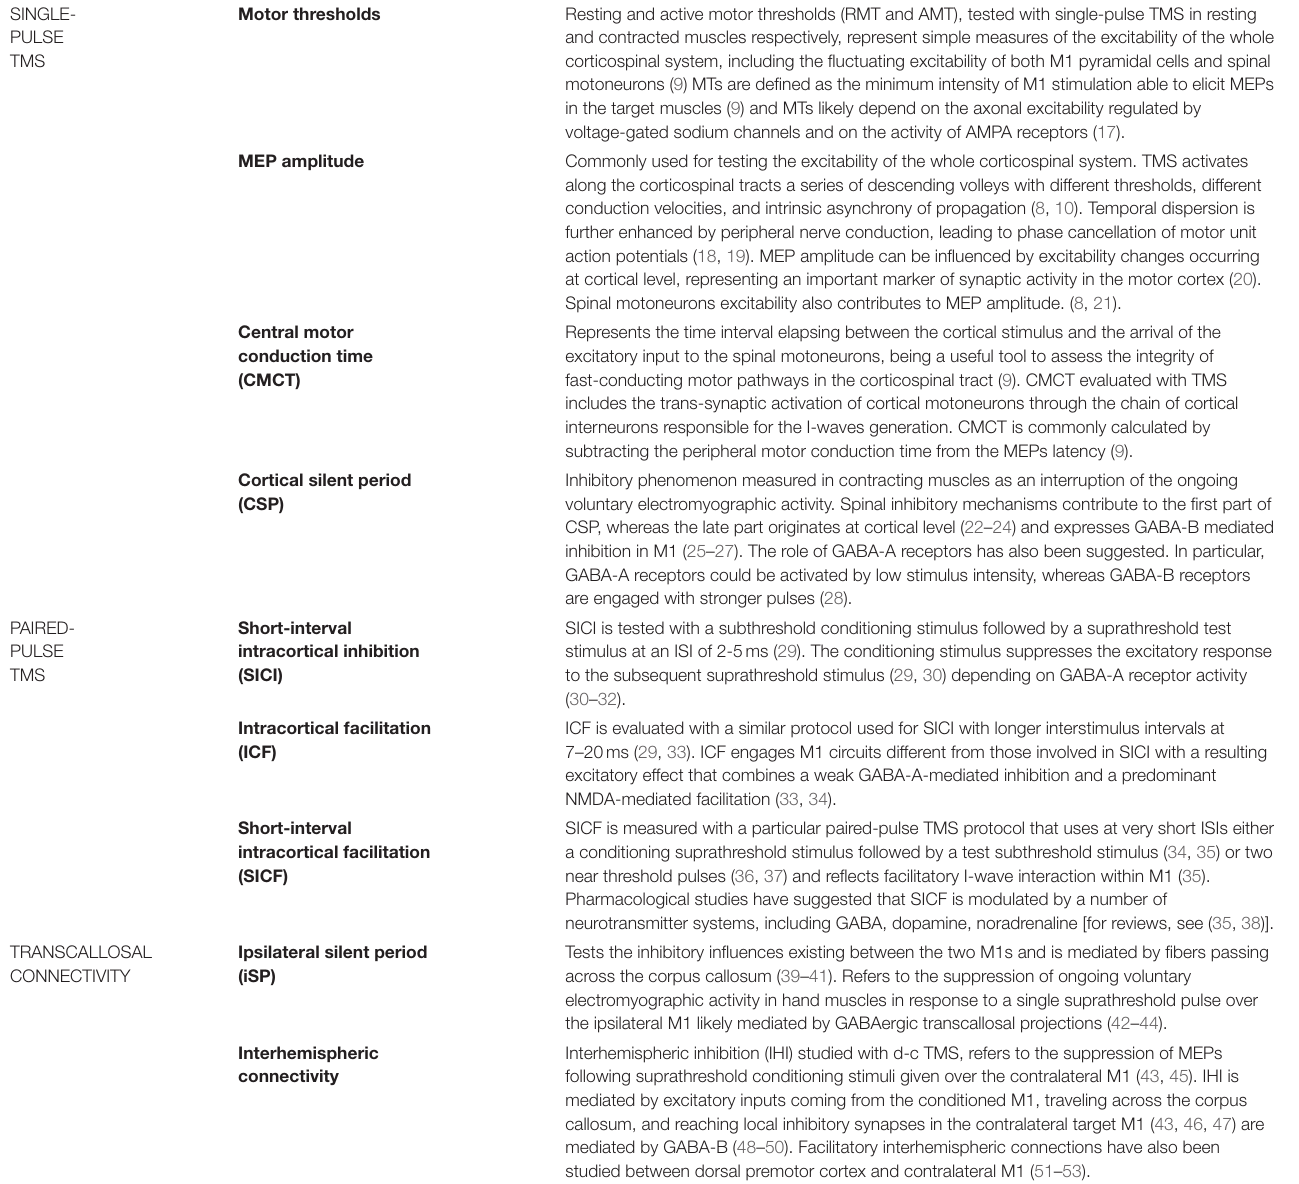
TABLE 1 | Main TMS protocols used to explore motor cortex pathophysiology in MS patients. SINGLE-